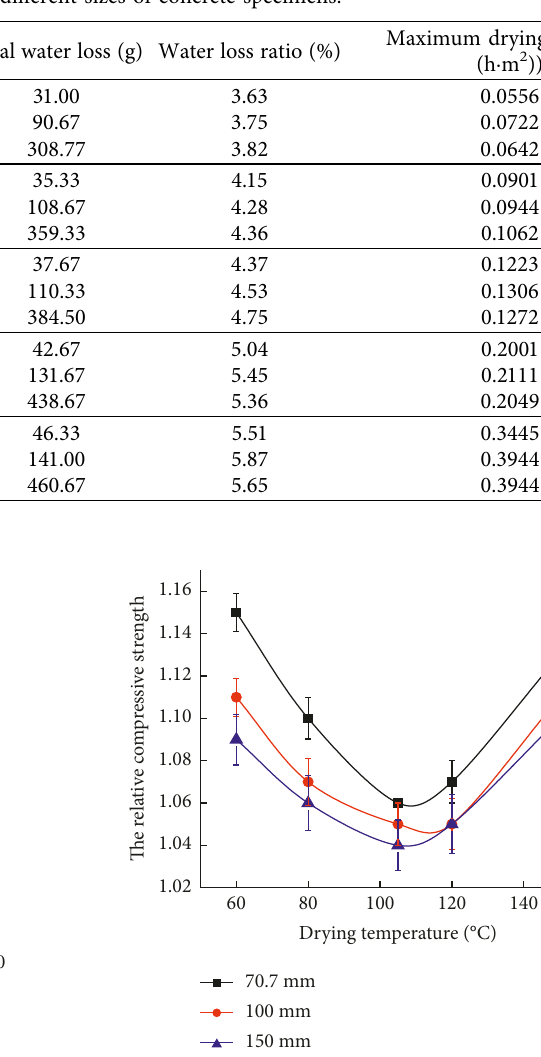
Table 2: Drying results of different sizes of concrete specimens.